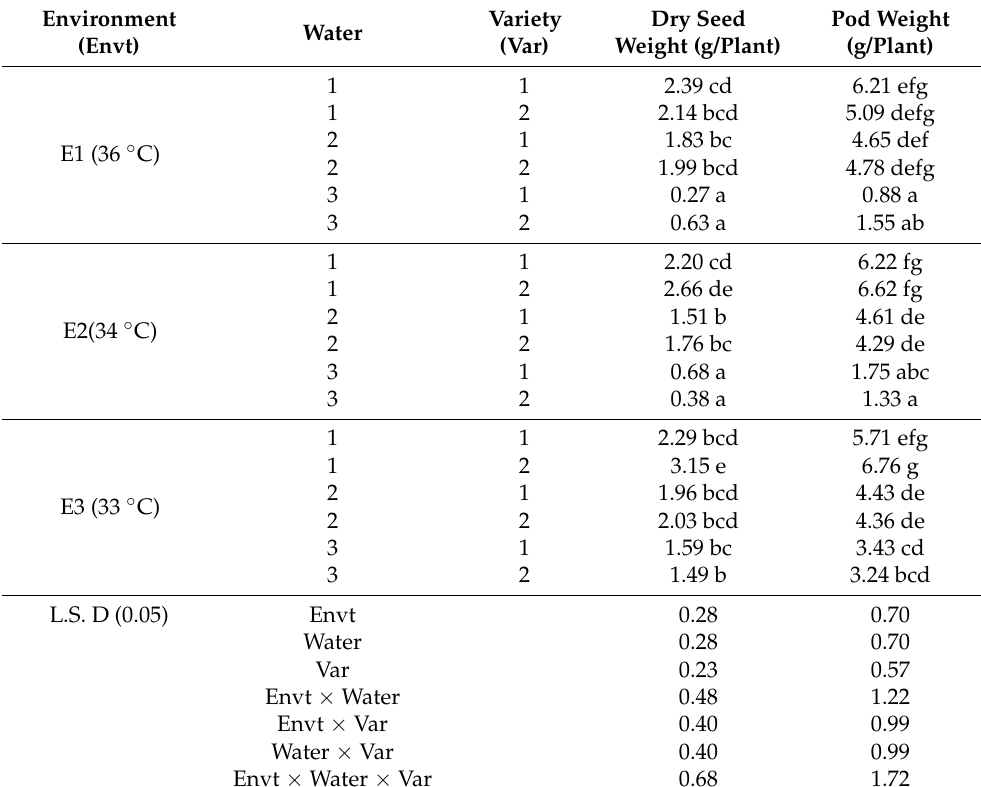
Table 3. Effects of environment and water as well as their interaction on seed weight and pod weight showing varietal differences. Variety Environment Water (Envt)